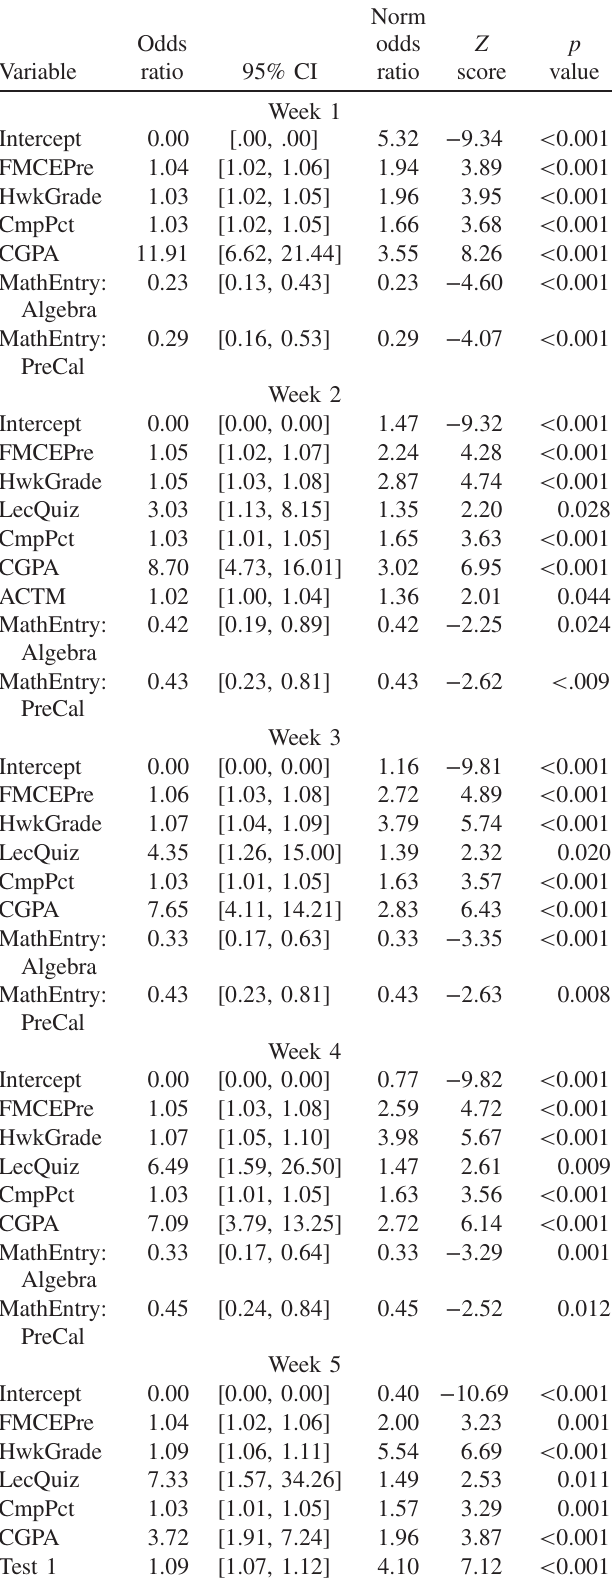
TABLE VI. Physics 1: Logistic models combining in-class and institutional